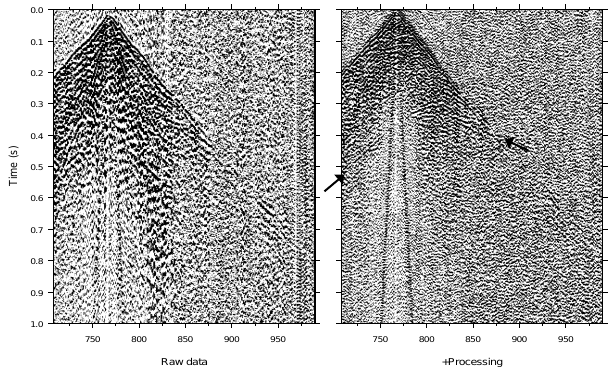
Fig. 3. Example of a shot gather without (left) and with (right) refraction statics and temporal filtering. Arrows mark a steeply dip- ping reflection that intersects the surface close to station 900. Hori- zontal axis is receiver